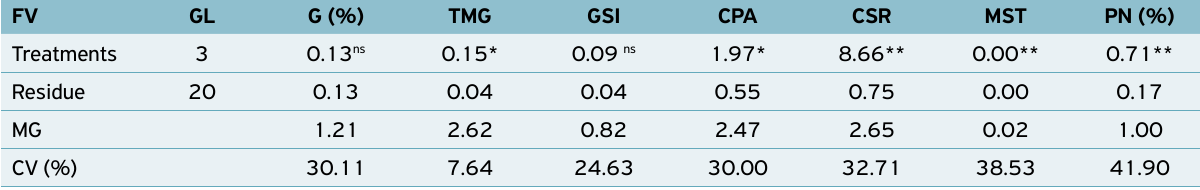
coefficient of variation; ns not significant by the F test of the analysis of variance; *significant at 5% probability level (p < 0.05); **significant at 1% probability level (p < 0.01).